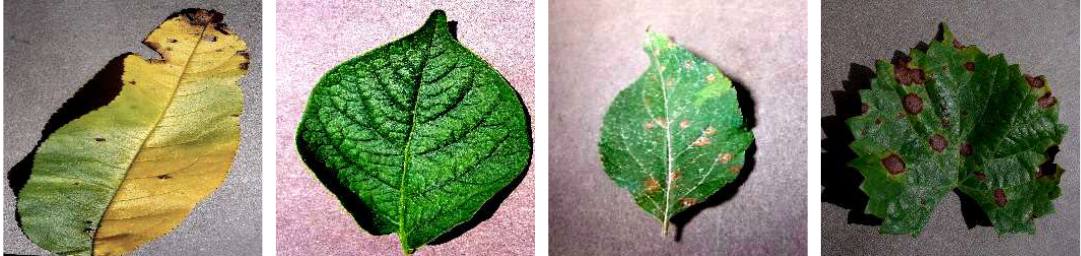
Figure 8. Sample augmented images using color augmentation techniques.